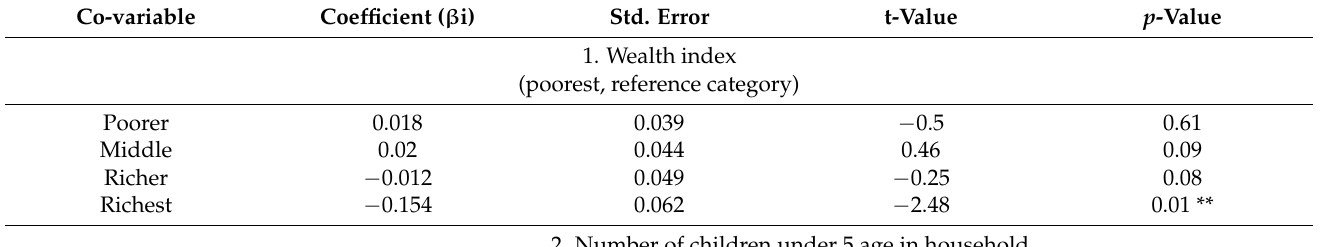
Table 3. Dummy Regression for Gender Disparity